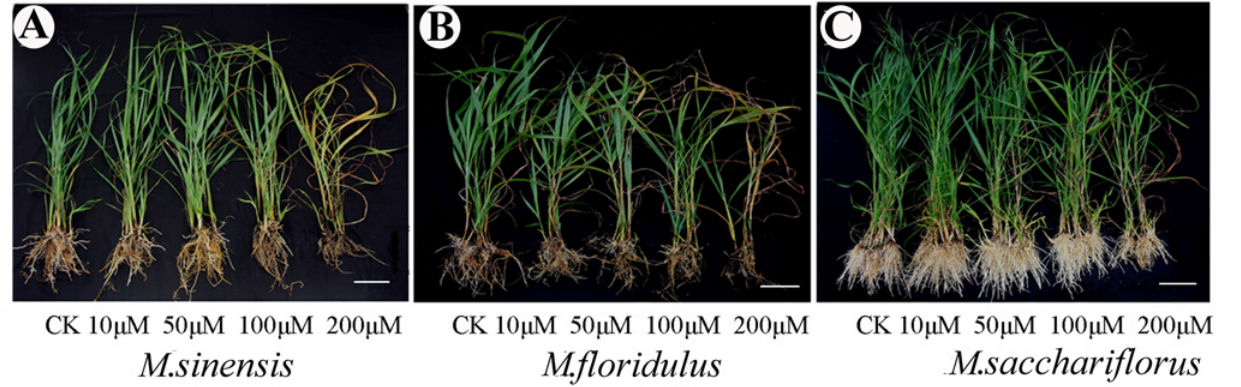
Fig 1. Effects of different Cd treatments on seedling growth and morphology of three Miscanthus species after 16 days of Cd treatment. Growth characteristics of seedlings of (A) M . sinensis , (B) M . floridulus and (C) M . sacchariflorus . Miscanthus seedlings (60-d-old) were grown in Hoagland nutrient solution (pH 6.0) containing 0, 10, 50, 100 and 200 μ M CdCl 2 for 16 days, respectively. Bar = 10 cm.